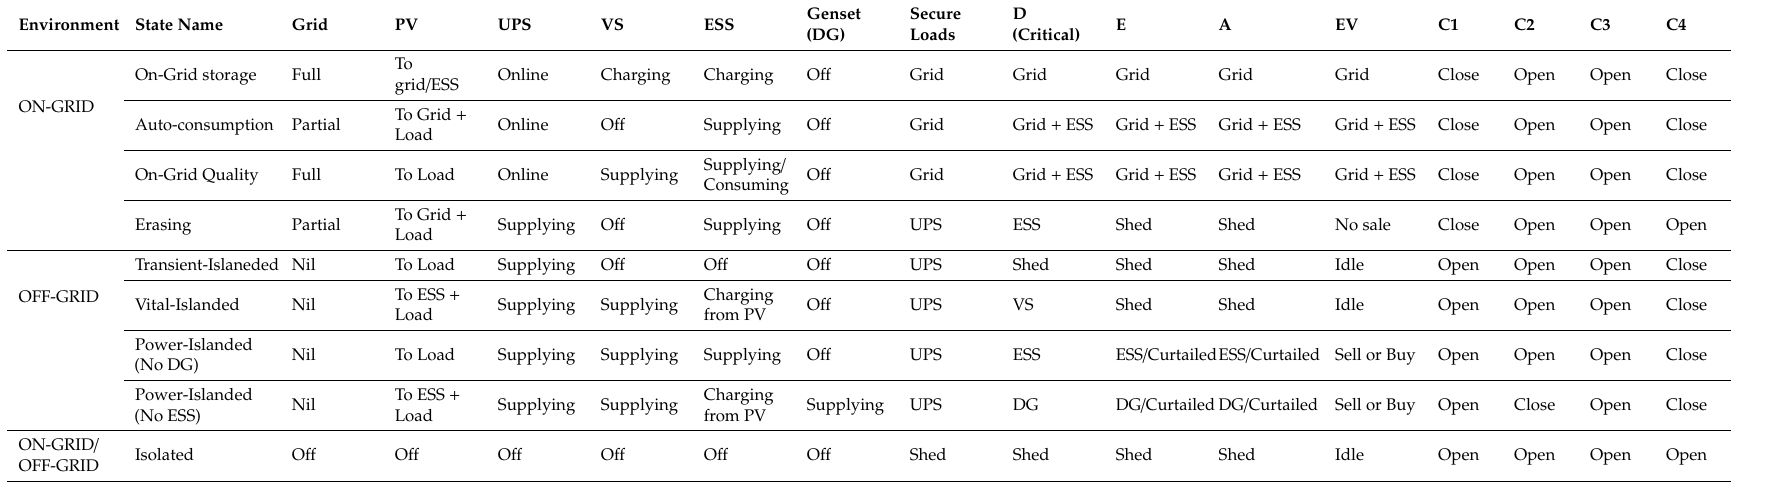
Table 2. Principle states defined in the microgrid